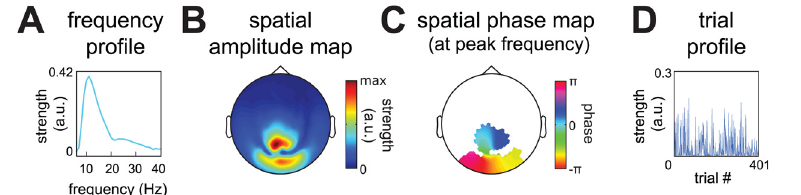
Fig 2. An example rhythmic component reflecting a posterior alpha source. Our decomposition method describes patterns of between-sensor phase coupling over frequencies and over trials by rhythmic components (see also Fig 1). These components are extracted from Fourier coefficients of electrophysiological recordings, which are obtained by a spectral analysis using multitapering. Components describe the systematic structure of Fourier coefficients over sensors, tapers, frequencies and trials and consist of four parameters sets. The frequency profile ( A ) describes the frequencies at which there is between-sensor phase coupling. The spatial amplitude map ( B ) describes which sensors have consistent between-sensor phase relations. The spatial phase maps ( C ) describe, per frequency, the between-sensor phase relations. The trial profile ( D ) describes how strongly a component is present in each trial by a single number. Importantly, the spatial amplitude map and the spatial phase maps describe phase coupling at the level of sensor-pairs, by maps at the level of individual sensors. The component depicted is a posterior alpha component, and is one of 15 components extracted from the representative dataset (see